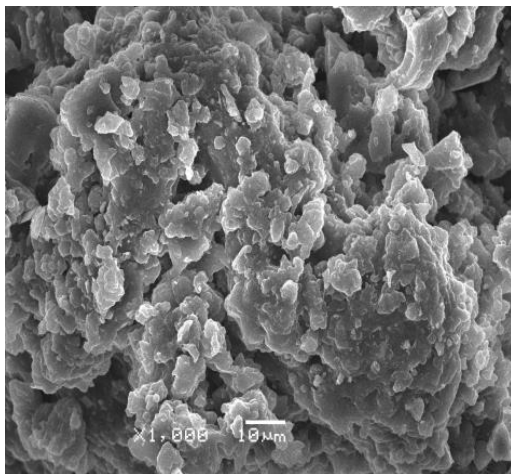
Figure 4. The SEM image of crumb rubber (×1000).